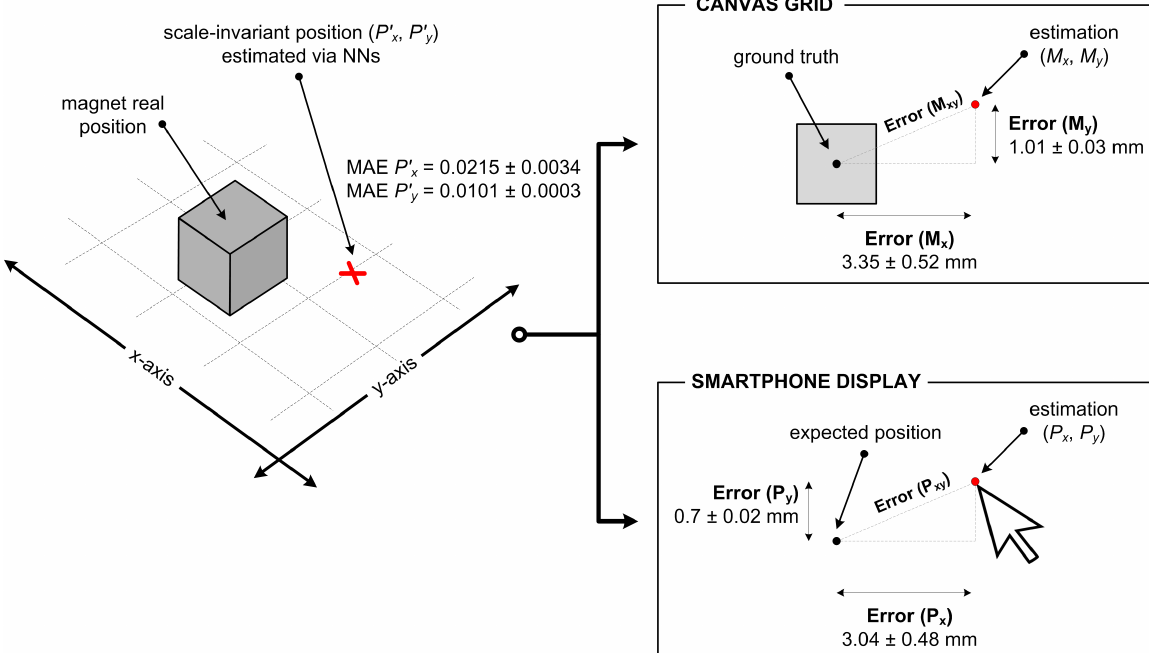
Figure 18. Visualization of the position estimation error, based on the obtained MAE